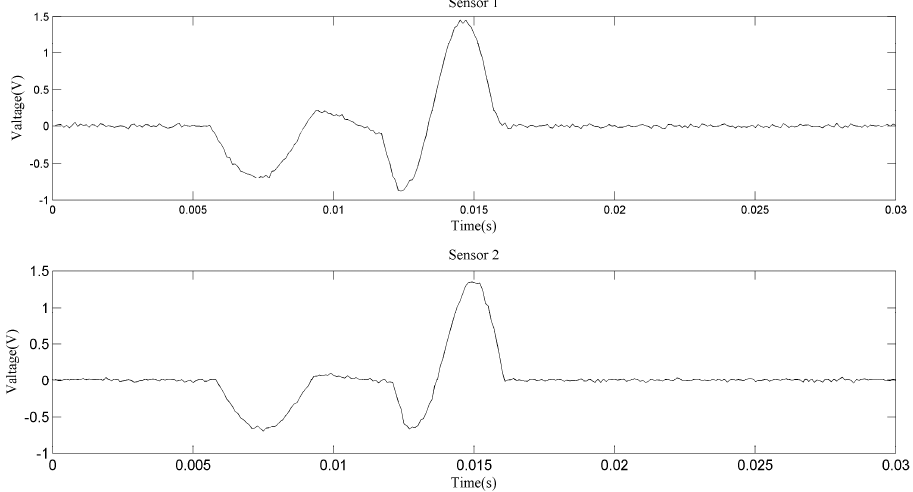
Figure 10. Aliasing signals of section a2.